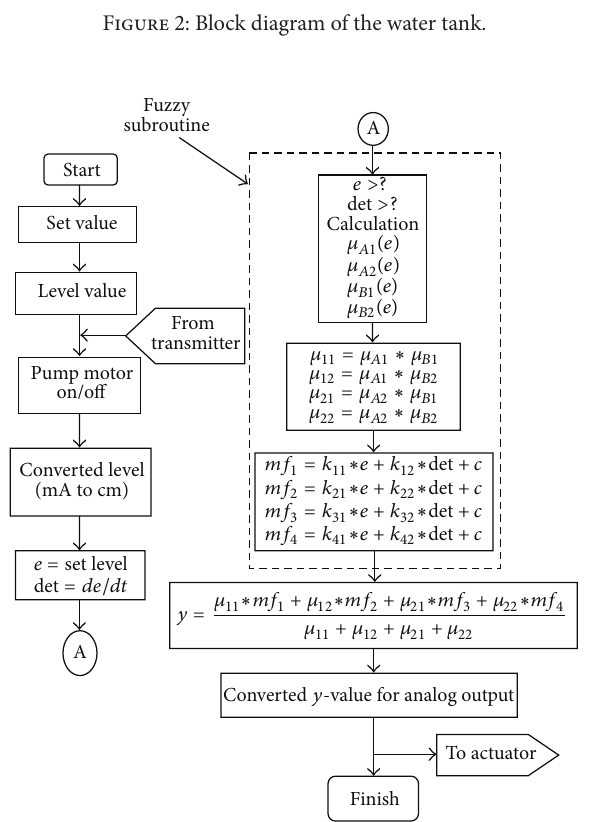
Figure 3: Flowchart of the PLC